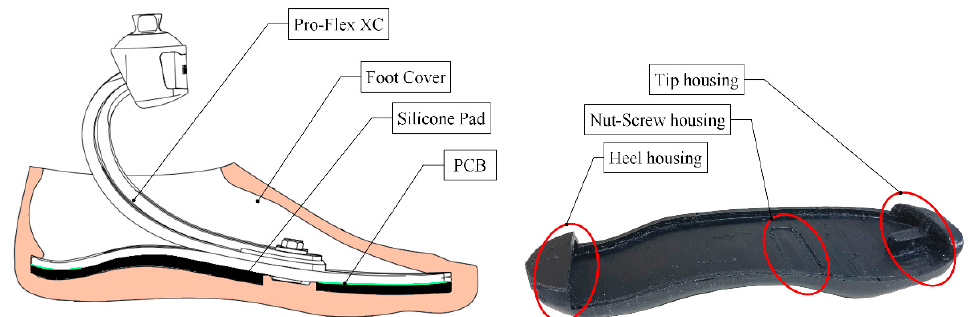
Figure 2. Positioning of sensitive elements below the carbon foot; highlighted are the modularity of PCBs, the sensitive elements in green, wiring paths, and the final assembling of the SPF. The vinyl sheet is used for assembling PCBs in a pre-defined configuration. The main components of the tactels are reported in section A-A: the silicone pad, the photodiode, the LED, and PCB.